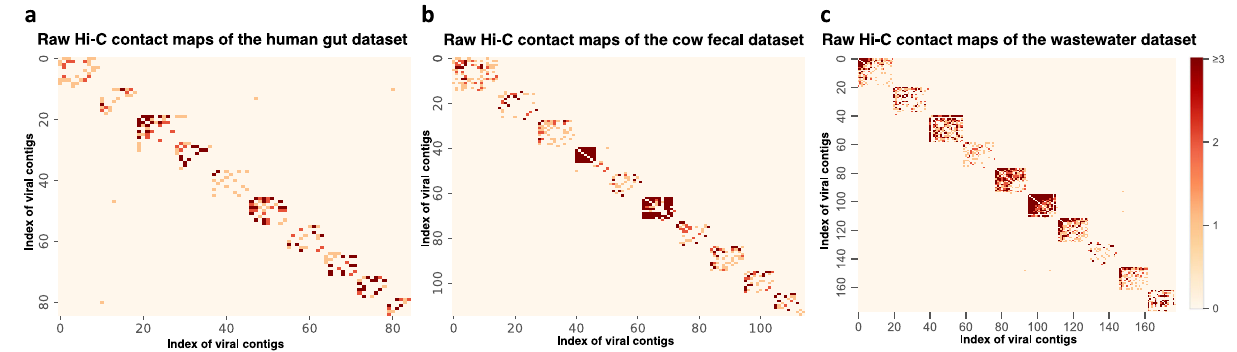
Fig. 4 | Heatmaps of raw Hi-C contact matrices of the top ten vMAGs from real metagenomicHi-Cdatasets. HeatmapsofrawHi-Ccontactmatricesofthetopten vMAGs from the ( a )humangut, ( b )cow fecal,and( c )wastewater datasetswiththe